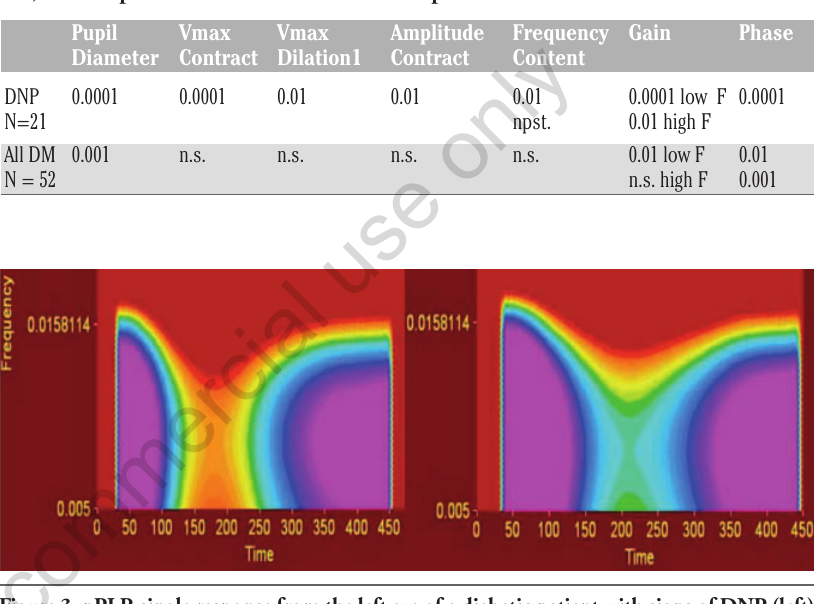
Table 4. Summary of the significancy of all recorded variables that discriminate DM patients from the normal group; out of seven parameters three, pupil diameter, gain and phase, distinguish all DM patients from healthy subjects. Therefore, the cPLR appears to be very important for this differentiation. Npst.: in column “frequency content”, we analyzed the total frequency content of three pPLR each for the same time span of 400 msec. Then we had to use a non-parametric statistical test (the Mann-Whitney rank sum test) for comparison of 5 normal with 5 DNP patients´ results.